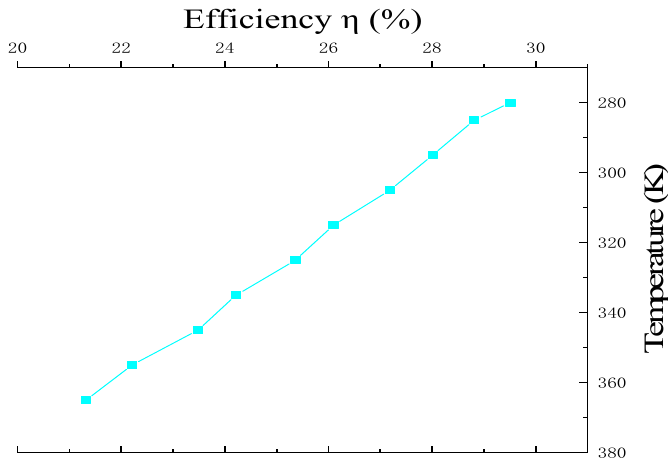
Figure 3. Efficiency curve under the fixed laser intensity (1 kw/m 2 ).